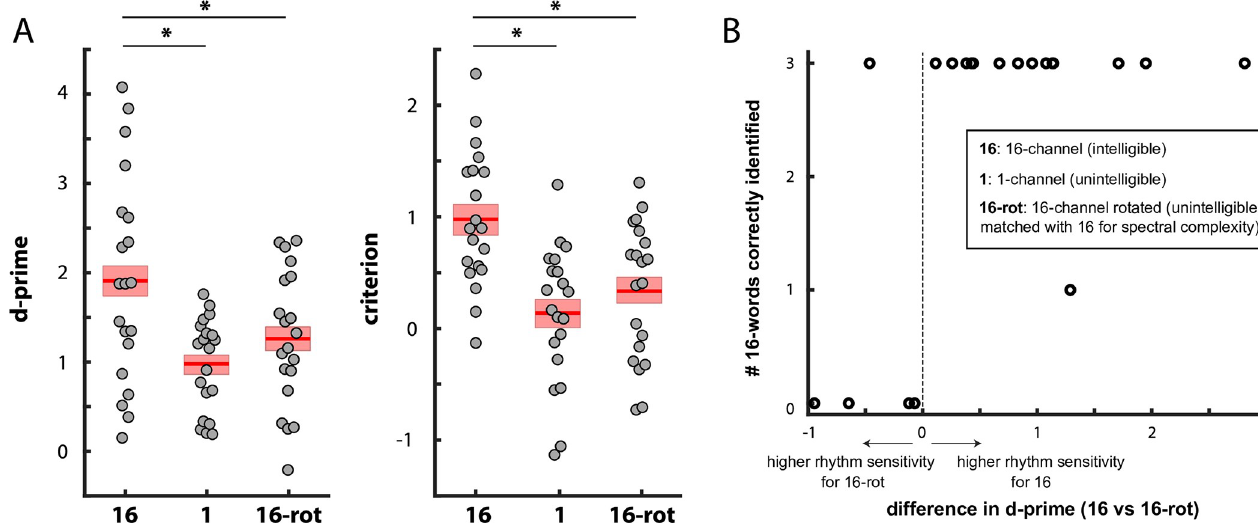
Fig 3. A. Sensitivity (d-prime) and response bias (criterion) during irregularity detection in Experiment 2. For other conventions, see caption of Fig 2. B. Number of correctly identified 16-channel vocoded words (between 0 and 3) as a function of the difference in irregularity detection performance (d-prime) between 16-channel and 16-channel rotated speech (shown in